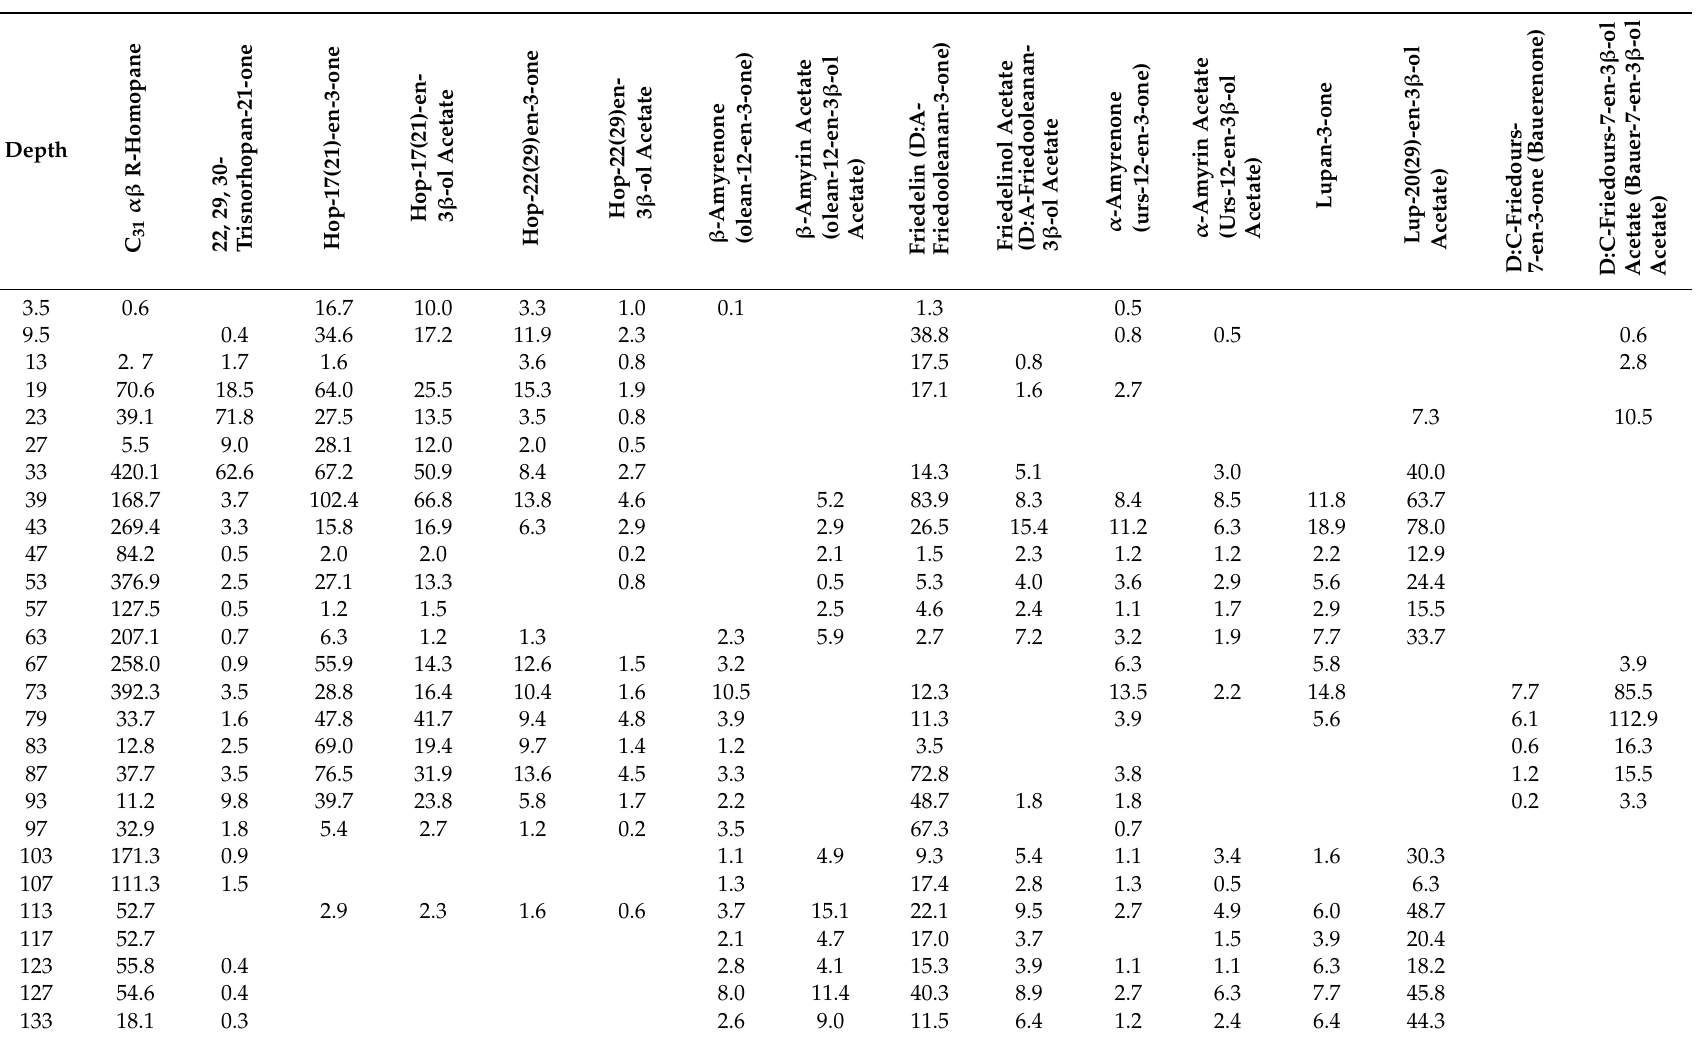
Table 2. Concentrations of triterpenoid derivatives ( µ g / g Corg) in the Roñanzas